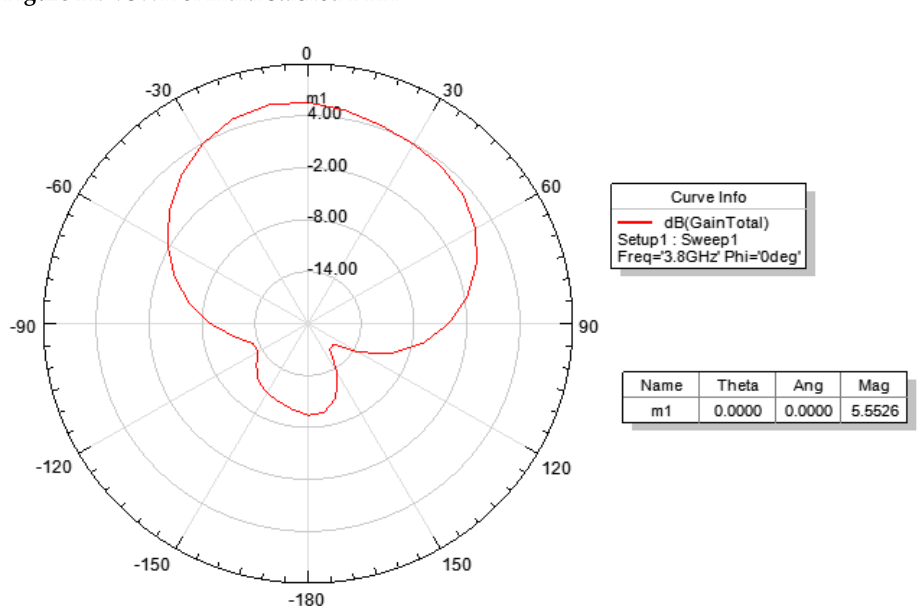
Figure 15. The Radiation pattern of Multi-stacked DRA (MSDRA).